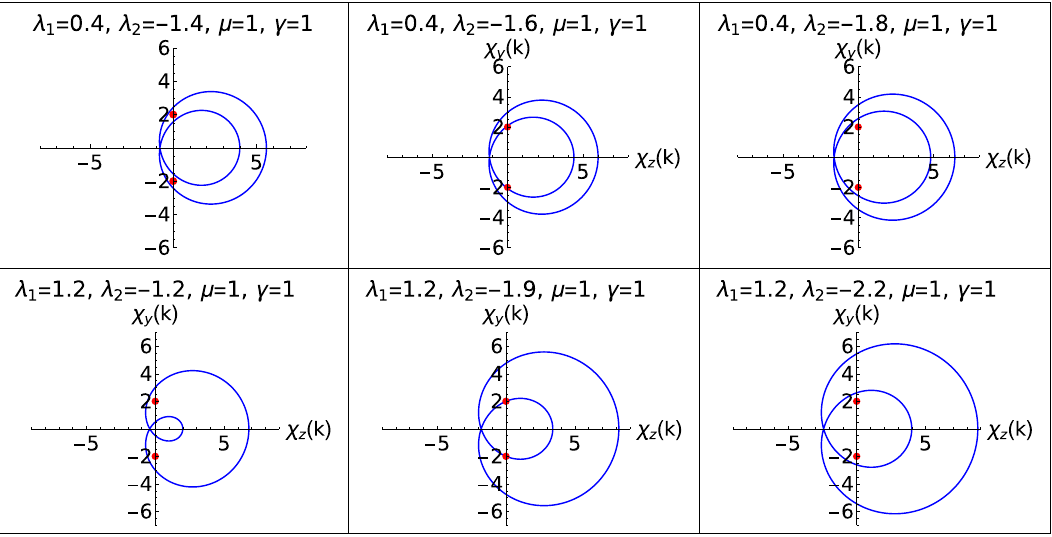
Figure 6. Parametric plots representing the topological phase transitions in the negative (cid:31) 2 region. Upper and lower panel corresponds to W=1–2 for different values of (cid:31) 1 respectively. Middle plot in both the panels represents the parametric curves at critical